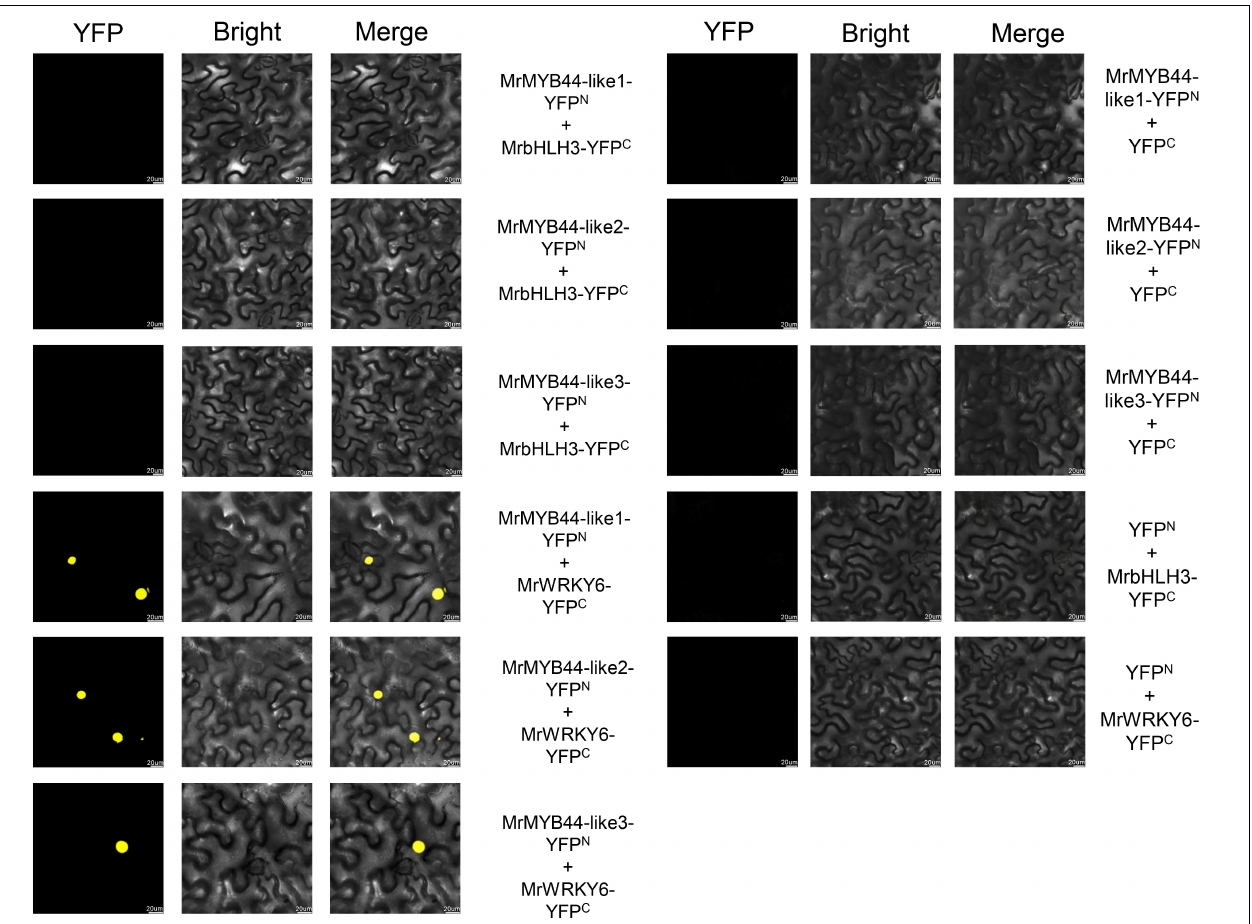
FIGURE 8 | Bimolecular fluorescence complementation assays showing that MrMYB44-like1/2/3 did not interact with MrbHLH3 but did interact with MrWRKY6 in nuclei of epidermal cells in Nicotiana benthamiana . Bars, 20 µ m.